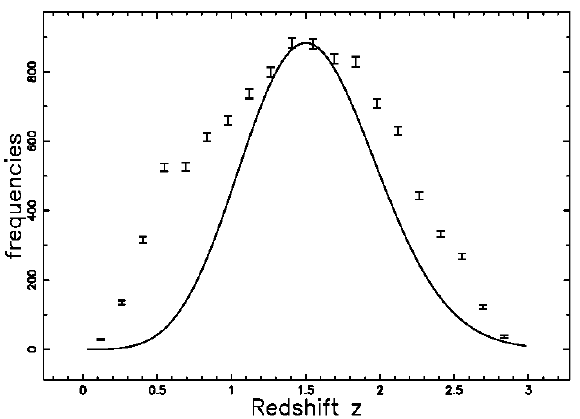
Figure 10. The QSOs with 20.16 ≤ m ≤ 20.85 are organized in frequencies versus spectroscopic redshift, points with error bars. The redshifts cover the range [ 0,3 ] and the histogram’s interval is 0.14. The maximum frequency of observed QSOs is at z = 1.478 and the number of bins is 20. The full line is ( z ) as given by the application of the truncated Schechter LF, the theoretical curve generated by dN d Ω dzdm which is Equation (52) with parameters as in Table 1 but M ∗ = − 22.5. The theoretical maximum is at z =